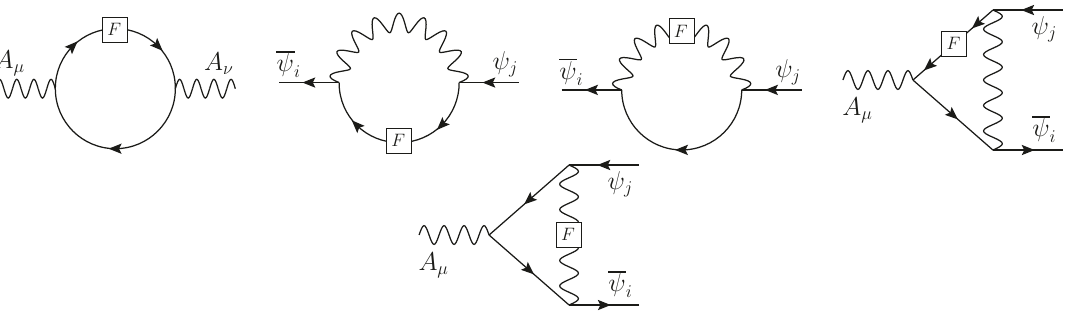
Figure 2 . The non-vanishing divergent one-loop diagrams with one S (1) penultimate diagrams also include the insertion on the other fermion